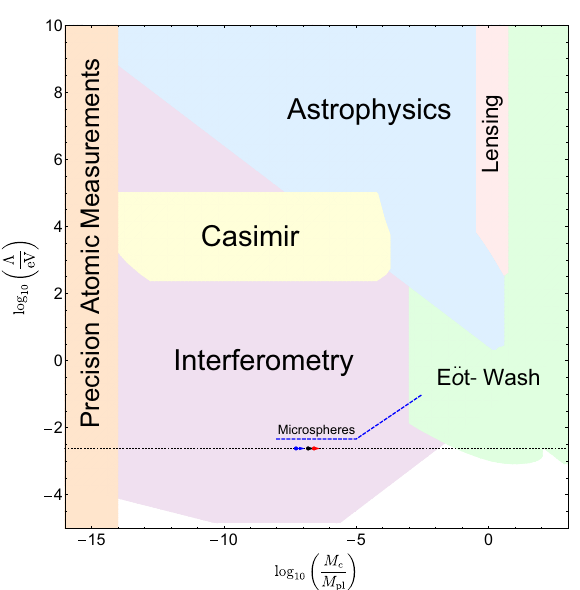
Fig. 4 Current bounds on the parameters M c and Λ for n = 1 chameleon models. The regions excluded by each specific test are indicated in the figure; the region labelled astrophysics contains the bounds from both Cepheid and rotation curve tests. The dashed line indicates the dark energy scale Λ = 2 . 4meV. The black, red, and blue arrows show the lower bound on M c coming from neutron bouncing and interferometry. The blue corresponds to the bounds of Lemmel et al. (2015) and the red to the bounds of Li et al.